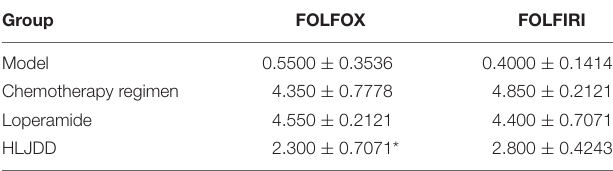
*p < 0.05 when compared with the respective chemotherapy regimen